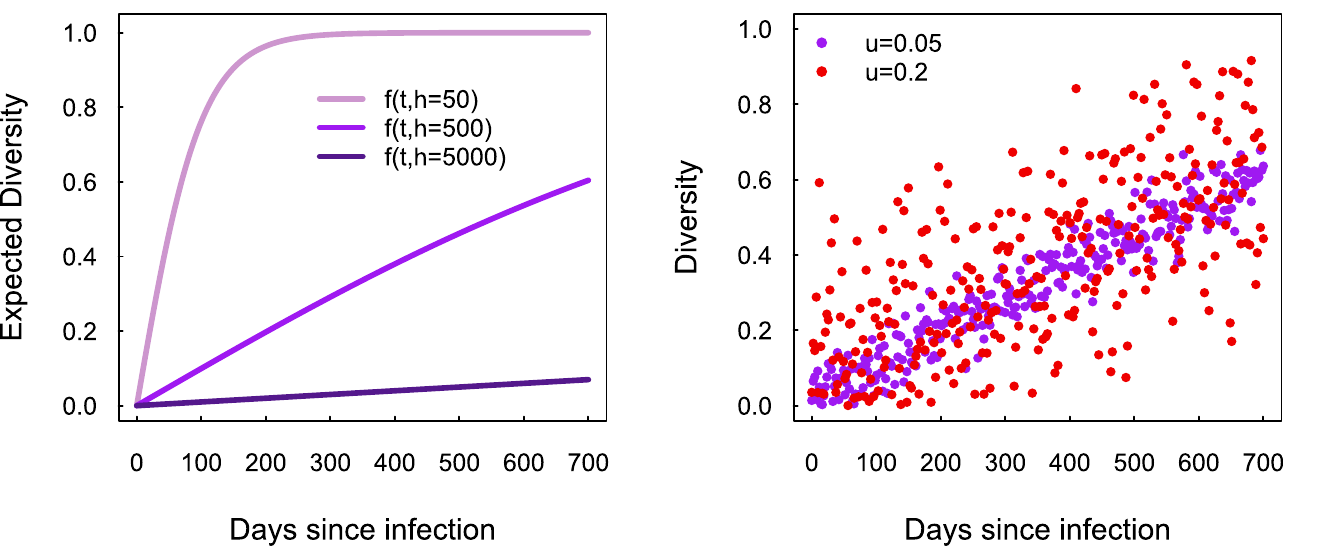
Fig 3. ( left ) Expected diversity evolution for different model behaviors, as determined by parameter h in Eq (3). ( right ) Diversity values of model f ( t ) with h = 500 for two standard deviation values: u = 0.05 (purple) and u = 0.2 (red). The profiles of real data commonly relate more to the case of u =